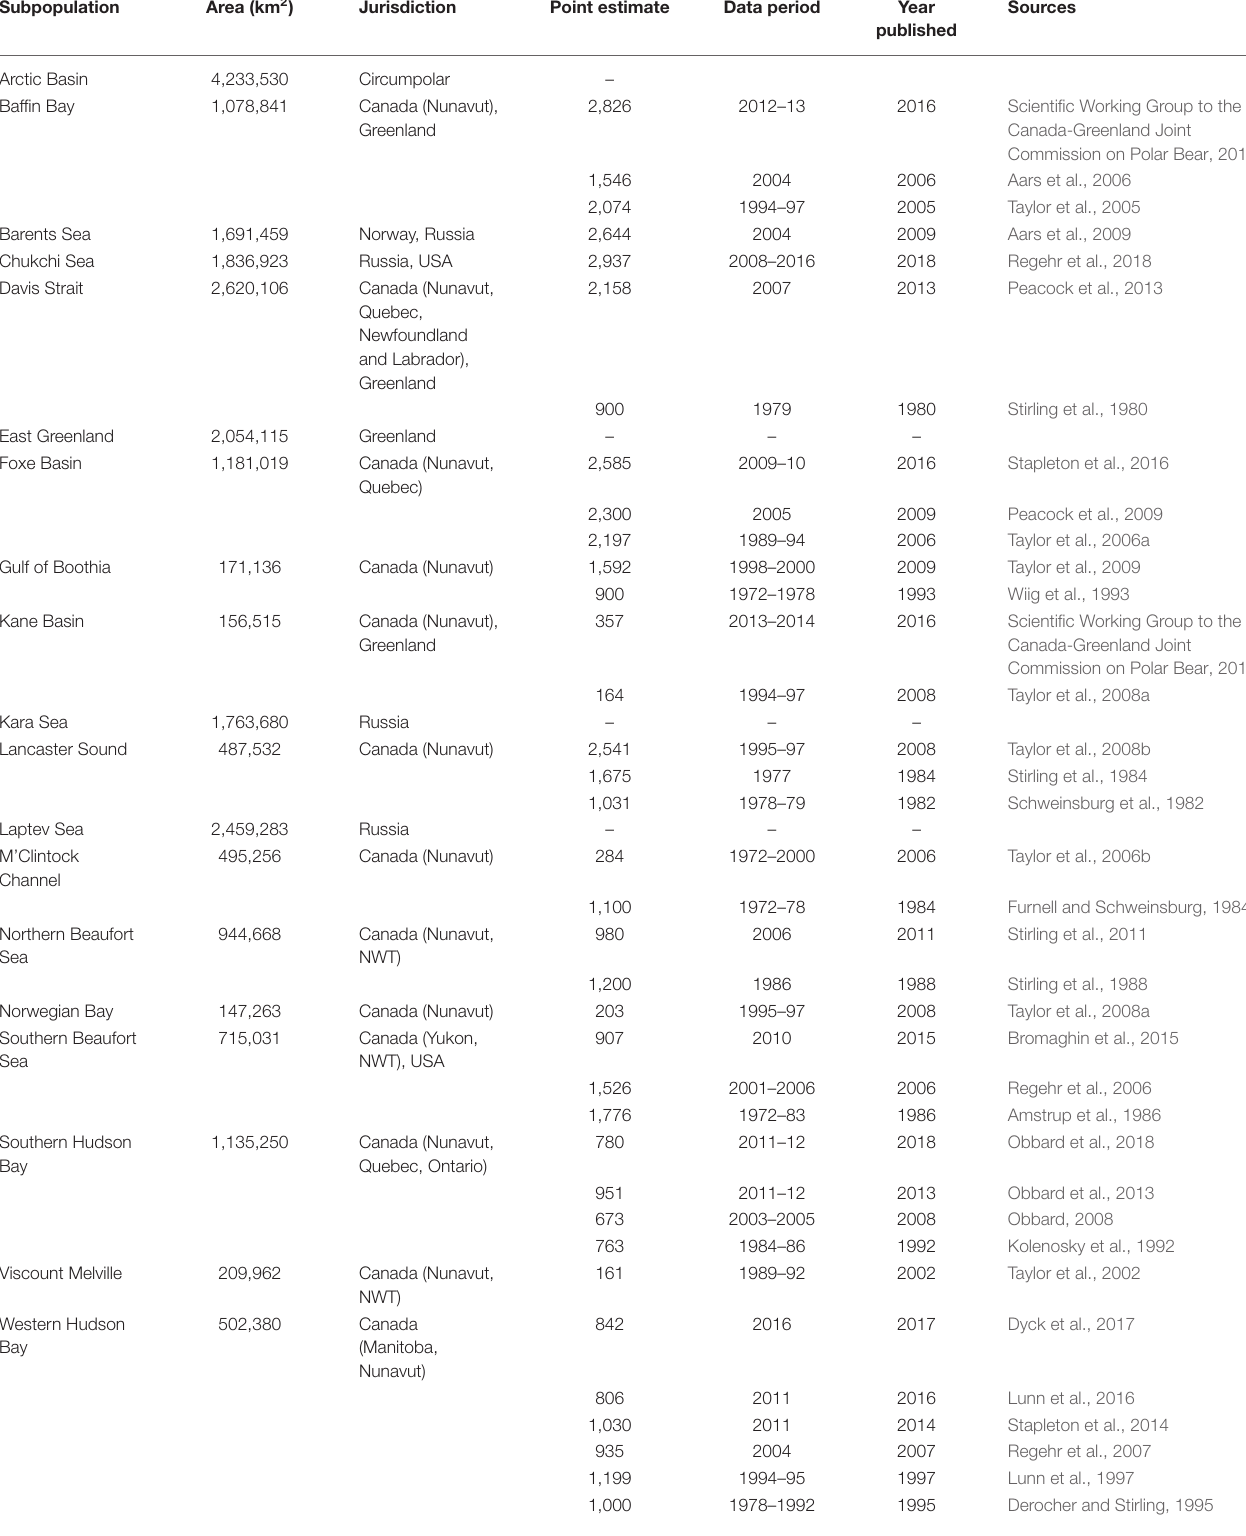
TABLE 1 | Information about polar bear populations (Polar Bear Specialist Group, 2021), their area, jurisdictions, and population estimates, including source references.